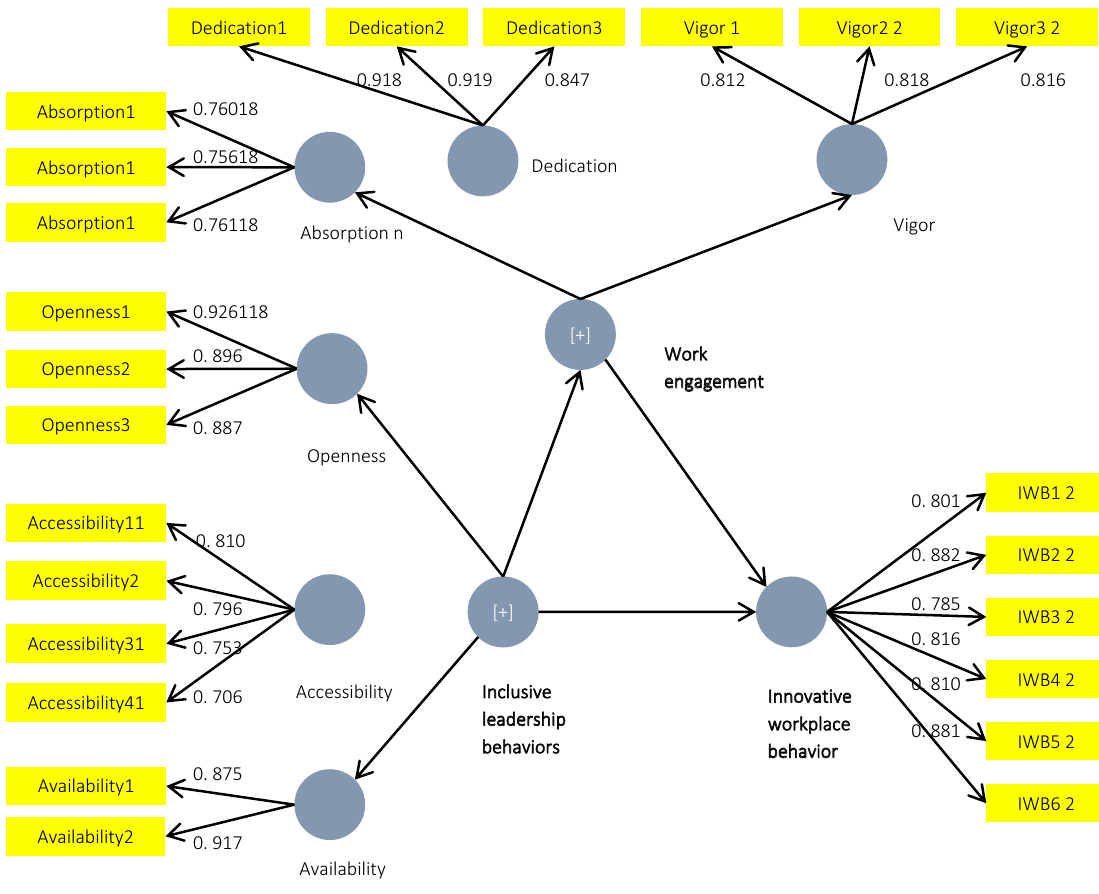
Figure 2. Structural model